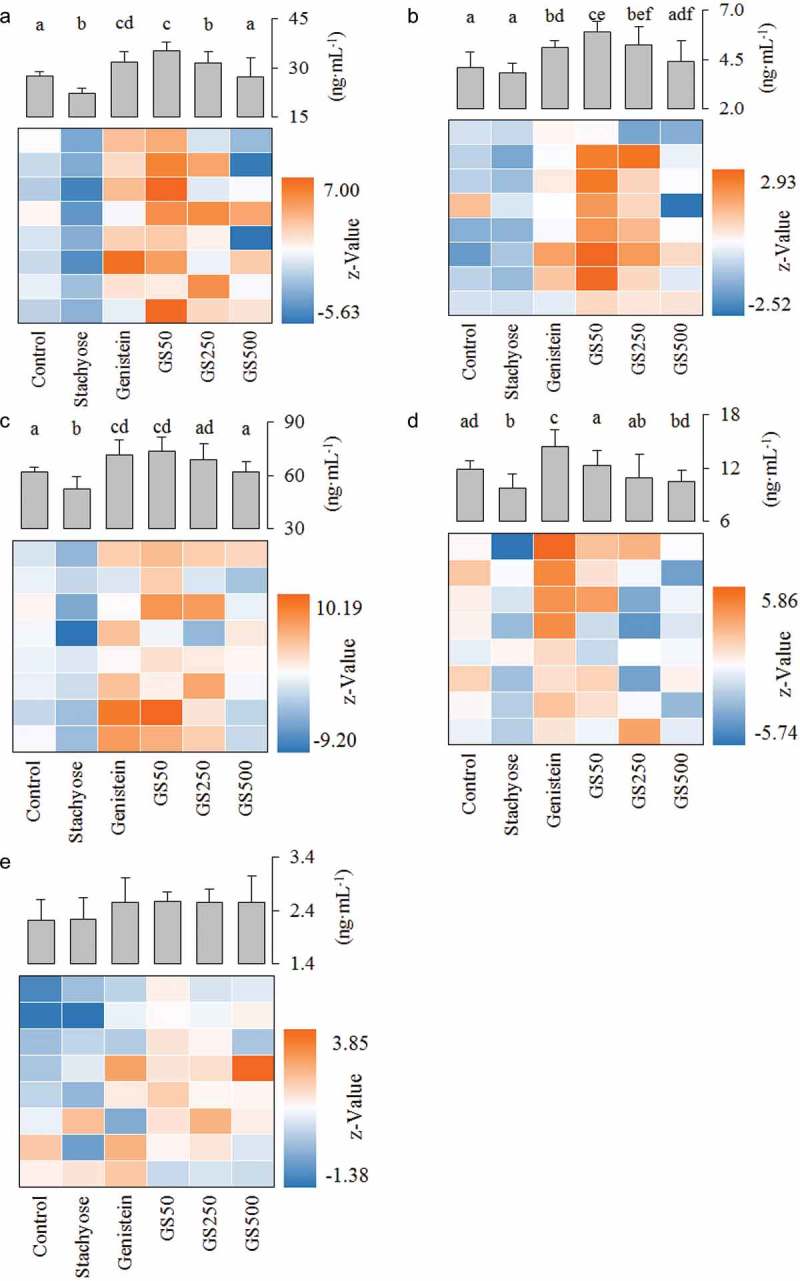
Effects of treatment of stachyose at different dose for 4 weeks on small intestinal UGT (a), SULT (b), P-gp (c), MRP1 (d), and MRP2 (e) levels, respectively. The color of the heat map reflects the Z-value of the concentration of protein. Z-value = (Xi-Xcontrol)/SDcontrol, where Xi is the level of a random metabolite in serum, Xcontrol is the average value of the serum level of normal diet-fed mice, and SDcontrol is the standard deviation of the metabolite level in the serum of normal diet-fed mice. The letters (a–f) denote that the mean values with different letters are significantly different from one another (p<0.05).